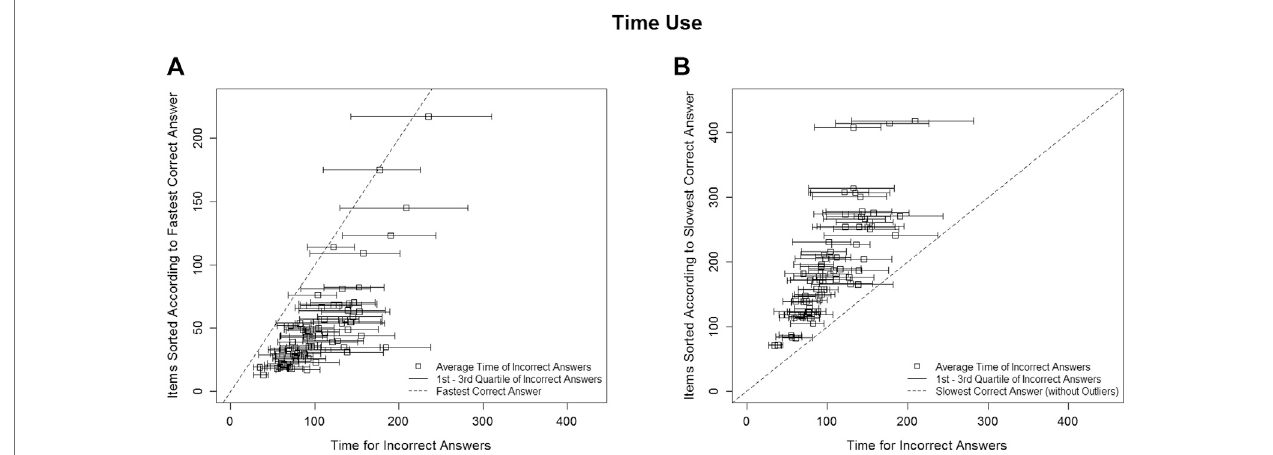
FIGURE 3 | Empirical time use for incorrect item responses compared to fastest (A) and slowest (B) correct